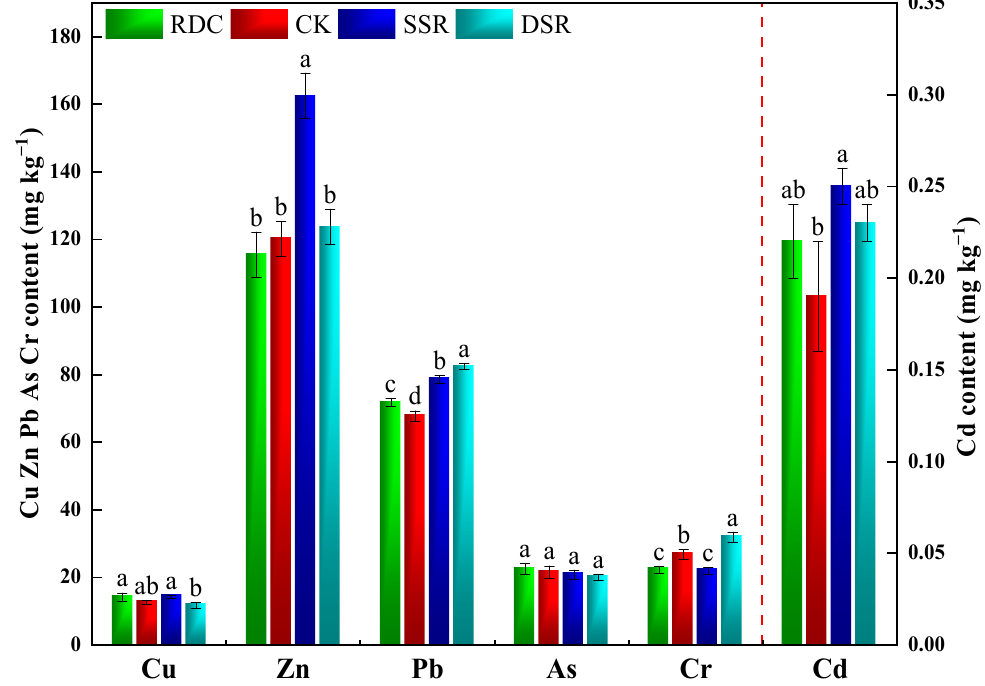
Figure 9. Contents of HMs in the surface soils of paddy fields. Small letters show the significant difference.